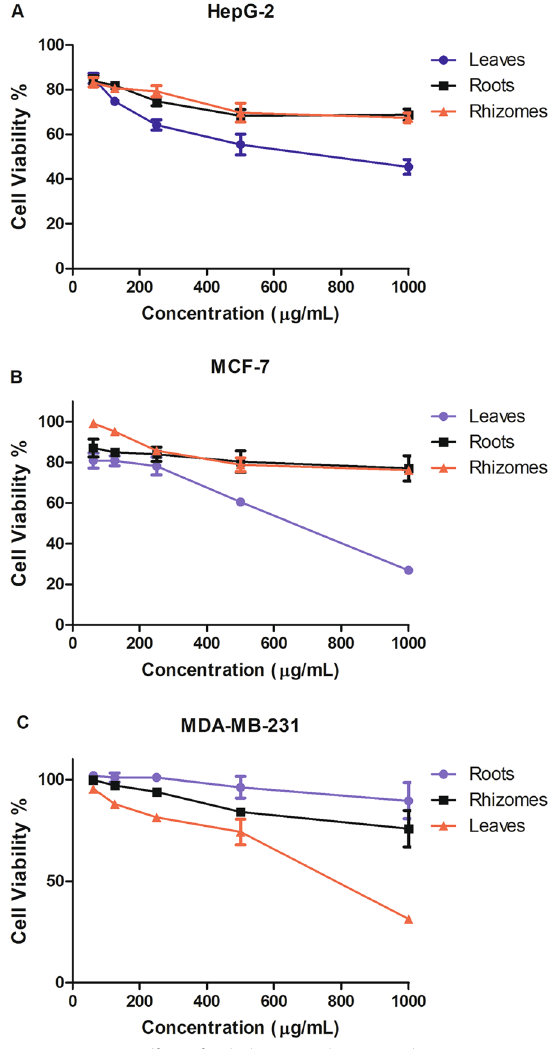
Fig. 4 Cytotoxic effect of Enhalus acoroides L, R, and RH on ( A ) HepG-2 ( B ) MCF-7, and ( C ) MDA-MB-231 for 48 h at concentration (31.25–1000 µg/ml). Data are expressed as a mean identical experiments made in three